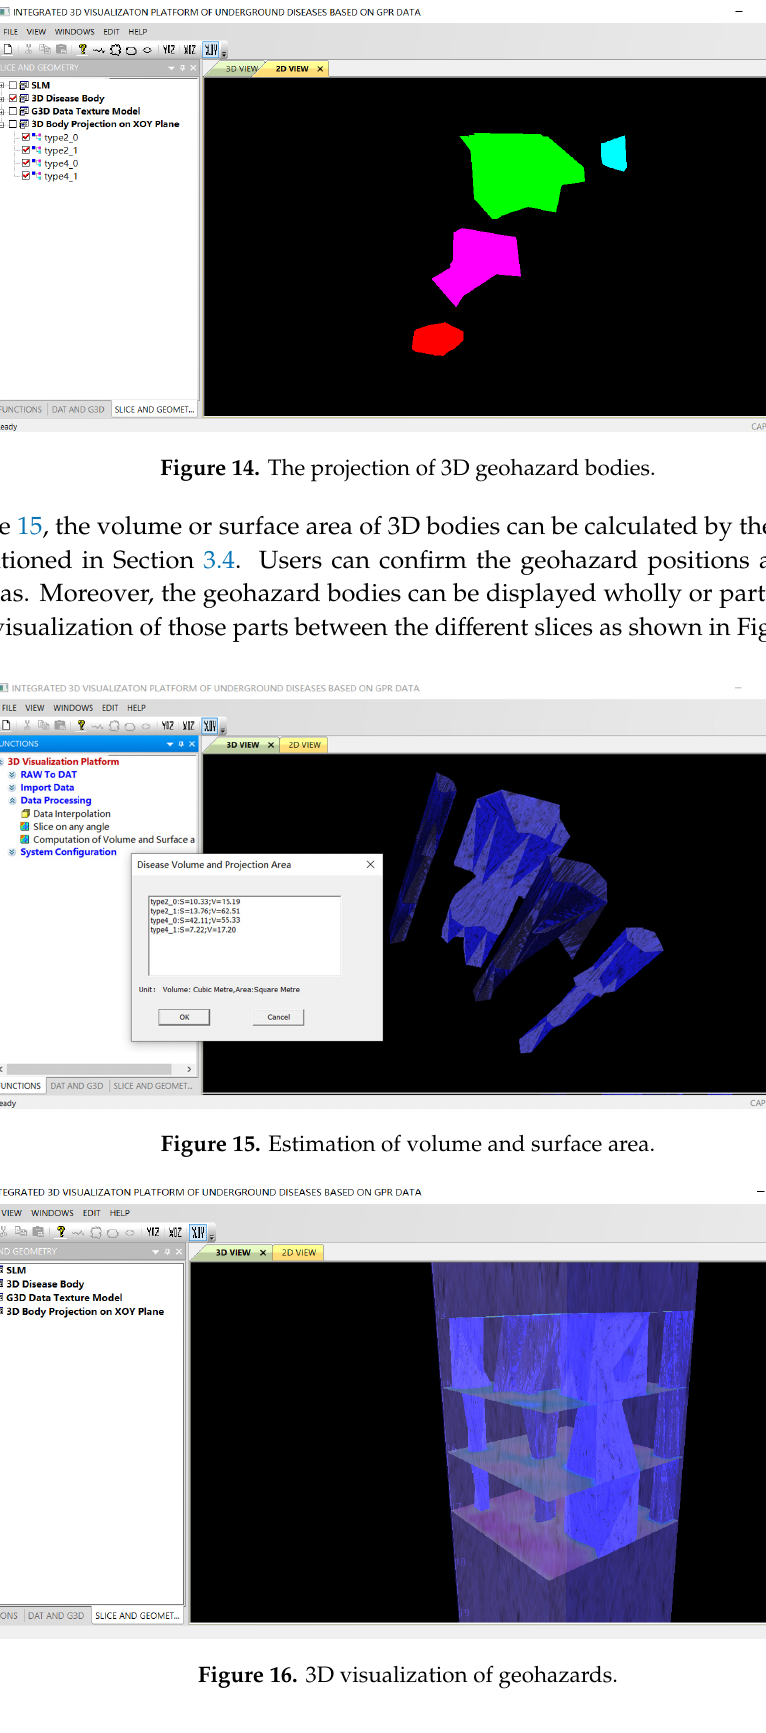
Figure 13. LC-TIN criterion configuration.